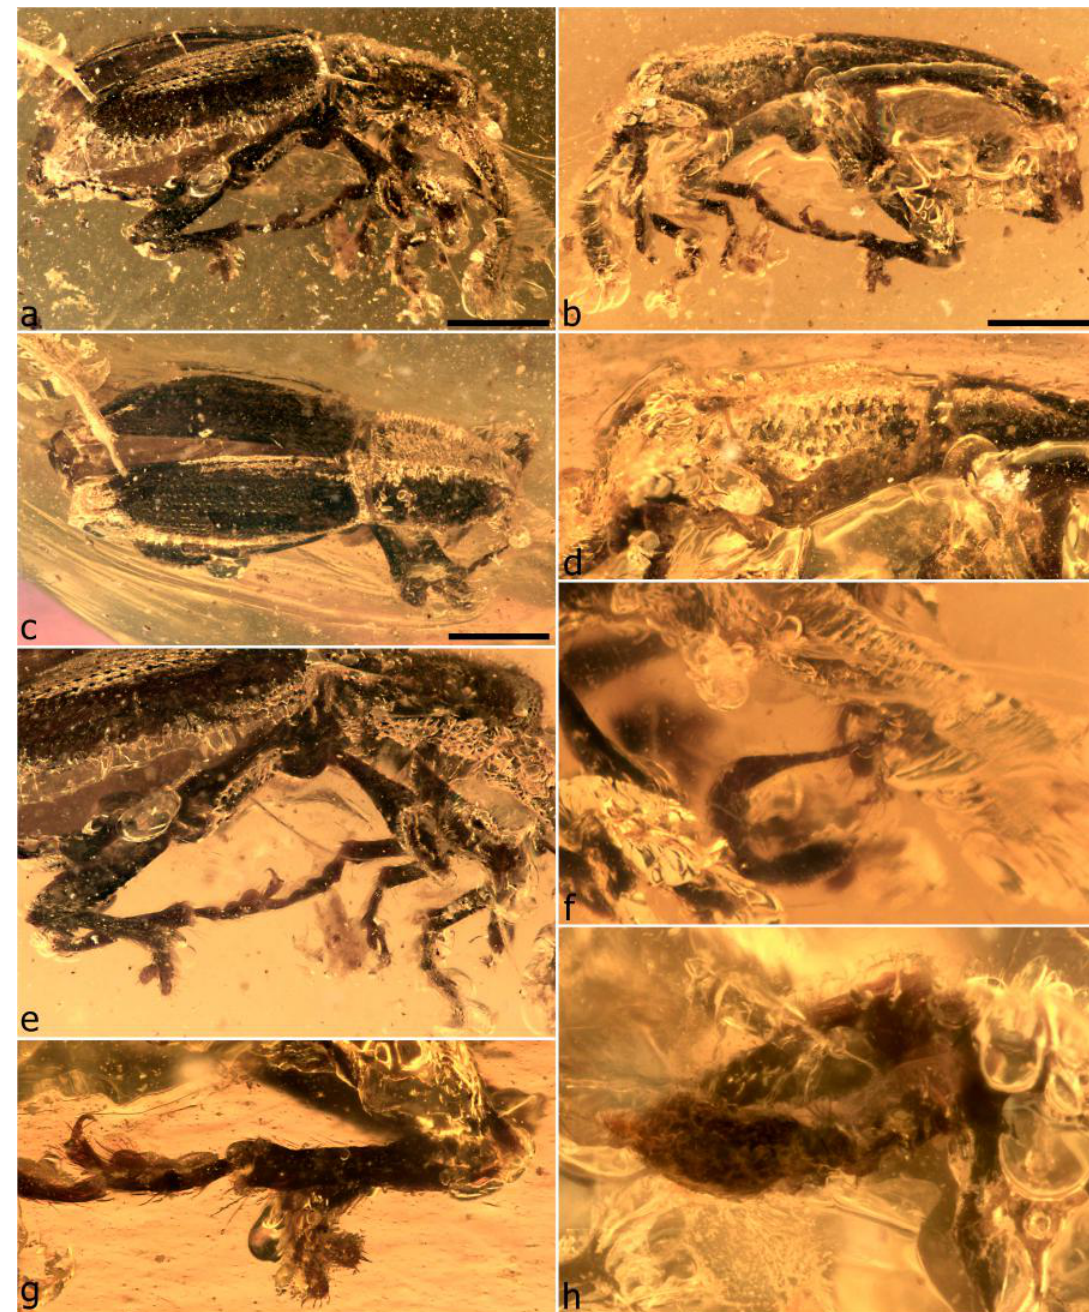
Figure 39. Petalotarsus curculionoides sp. n., paratype. Habitus, right lateral ( a ); habitus, left lateral ( b ); habitus, dorsal ( c ); head, prothorax and elytral humerus, left lateral ( d ); elytra and legs, right lateral ( e ); right antenna ( f ); left metatibia and -tarsus ( g ); antennal club ( h ). Scale bars: 1.0 mm (a–c). Material examined. Holotype (NIGP154216): reasonably well preserved, intact specimen, not compressed or distorted, not well visible; diagonally in centre of thin rectangular cuboid 7.5 × 7.2 × 3.5 mm; amber dark, clear on left side of specimen but cloudy on right side, with large warped film posteriorly on ventral side, wrapping over middle and hindlegs, and with large crack along middle of elytra and right around specimen, with many small impurities especially on right side of specimen. Derivation of name . The species is named for its cylindrical body shape, the name being a Latin